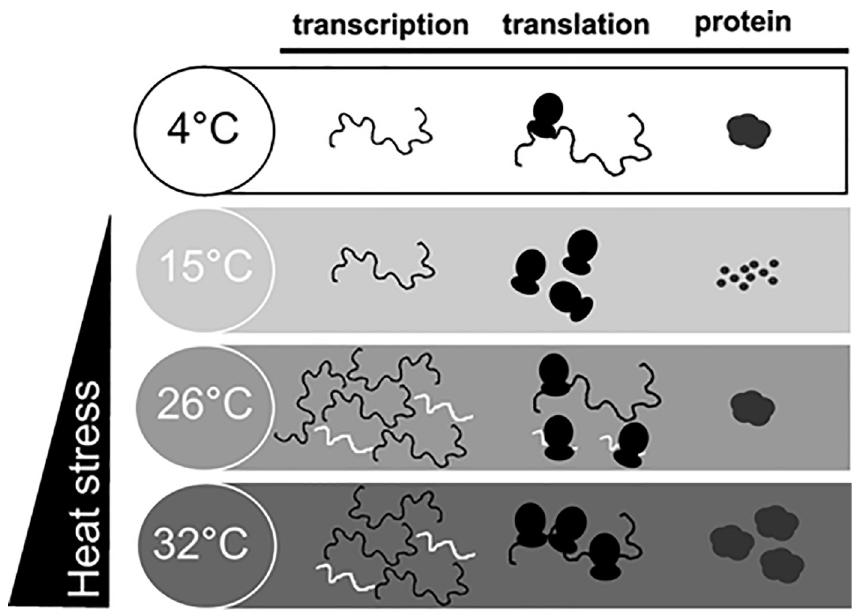
Fig 5. Scheme summarizing the multi-level changes occurring during heat shock in Diamesa tonsa .